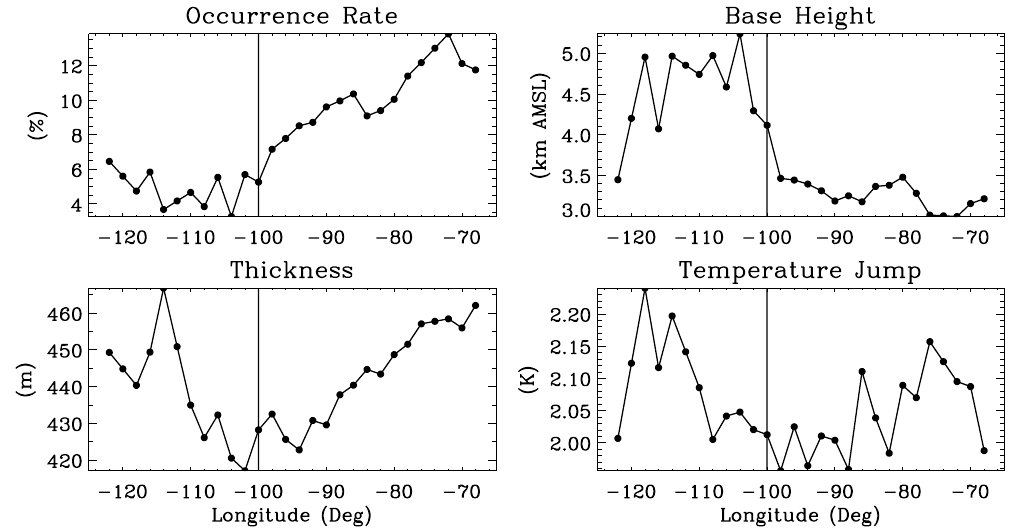
Fig. 7. Longitudinal variation of meridionally averaged occurrence rate, base height, thickness, temperature jump of lower tropospheric inversions over 56 stations in 1998–2007.